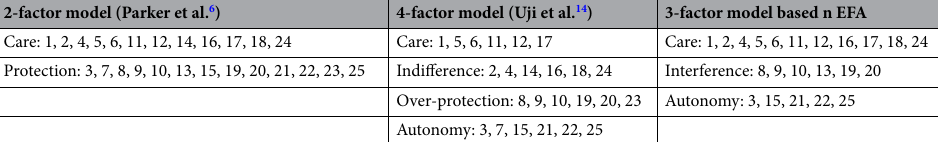
Table 7. Confirmatory factor models in the present study.